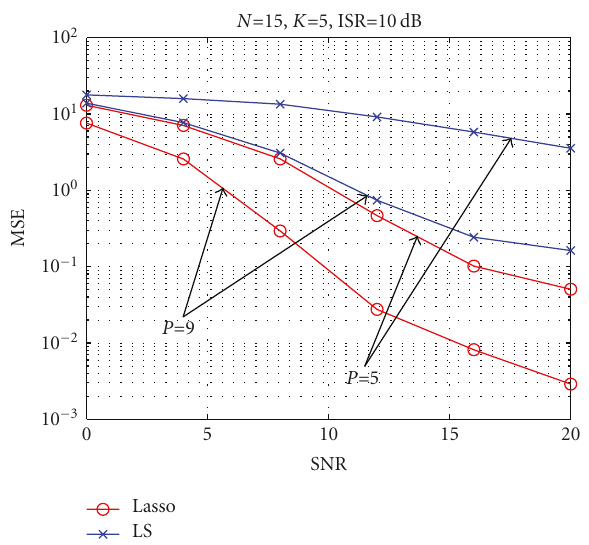
Figure 4: Mean-square error of the users’ time delay versus SNR in a near-far scenario (chip-synchronous system with AWGN and known K ).